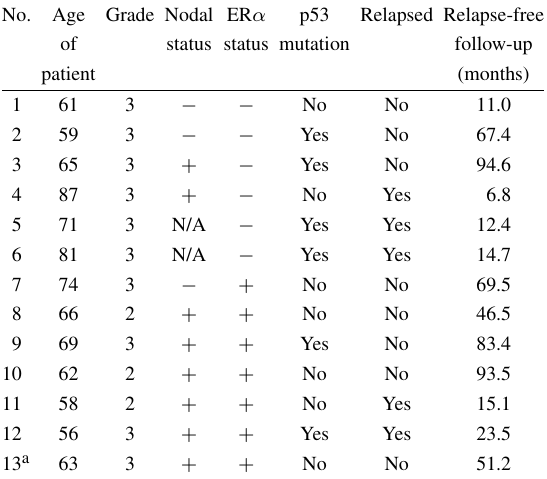
Clinical characteristics of human breast carcinoma